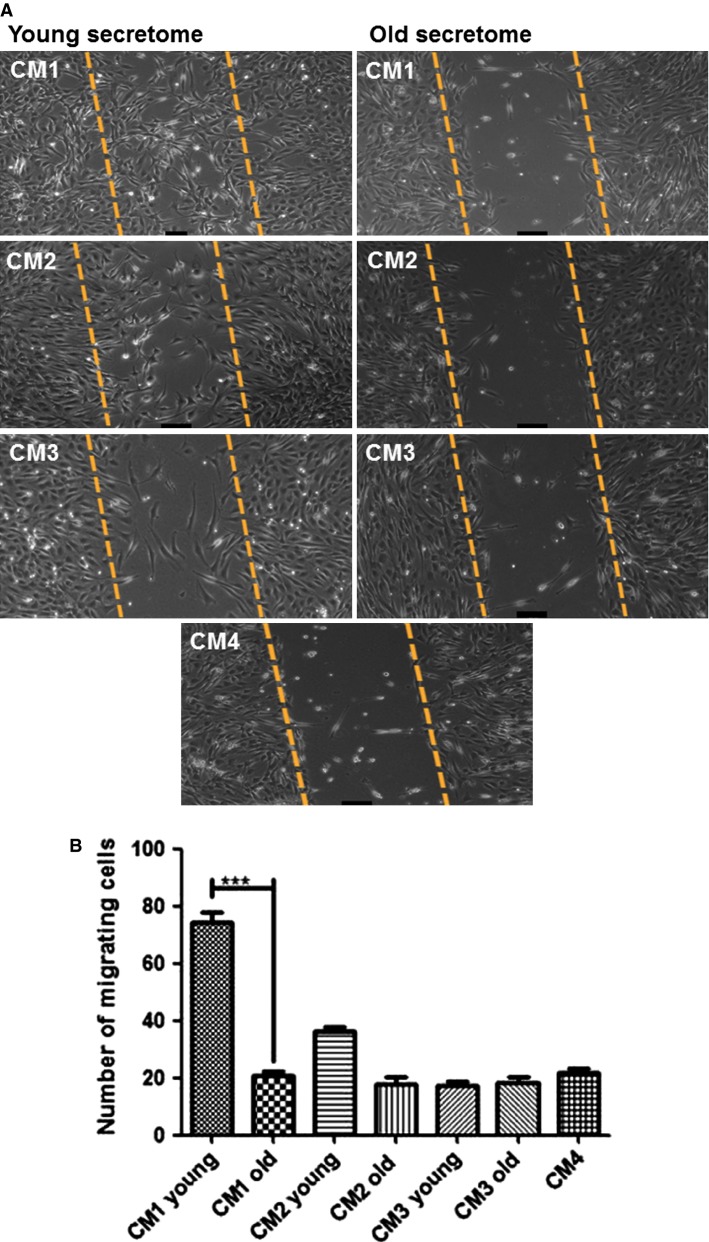
(A) Images of migrated cells for each condition. Myoblasts migration in response to the young and old secretome after 18 h. A quantitative analysis of the invaded area was four fold higher in the presence of young secretome old, ***P < 0.0001. All CMs (CM2–4) were not significantly different, P > 0.05 (B). The results were obtained from at least four independent experiments.